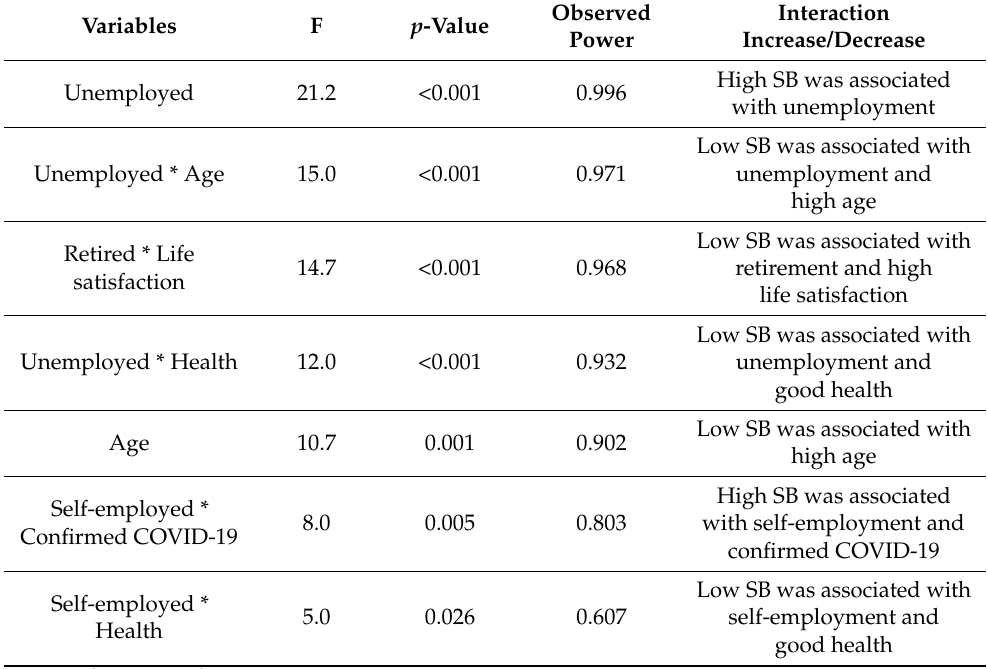
Table 4. Interaction model for SB over